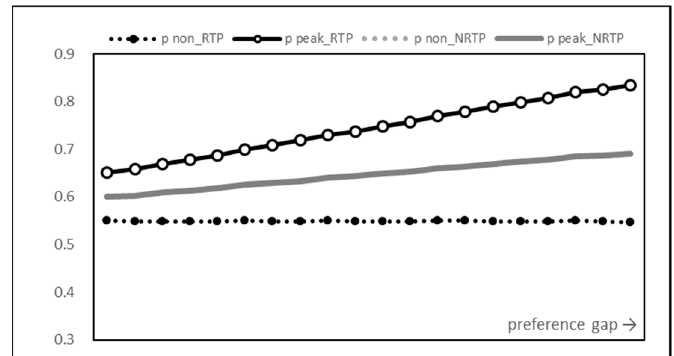
Figure 12. Supplier price graph.